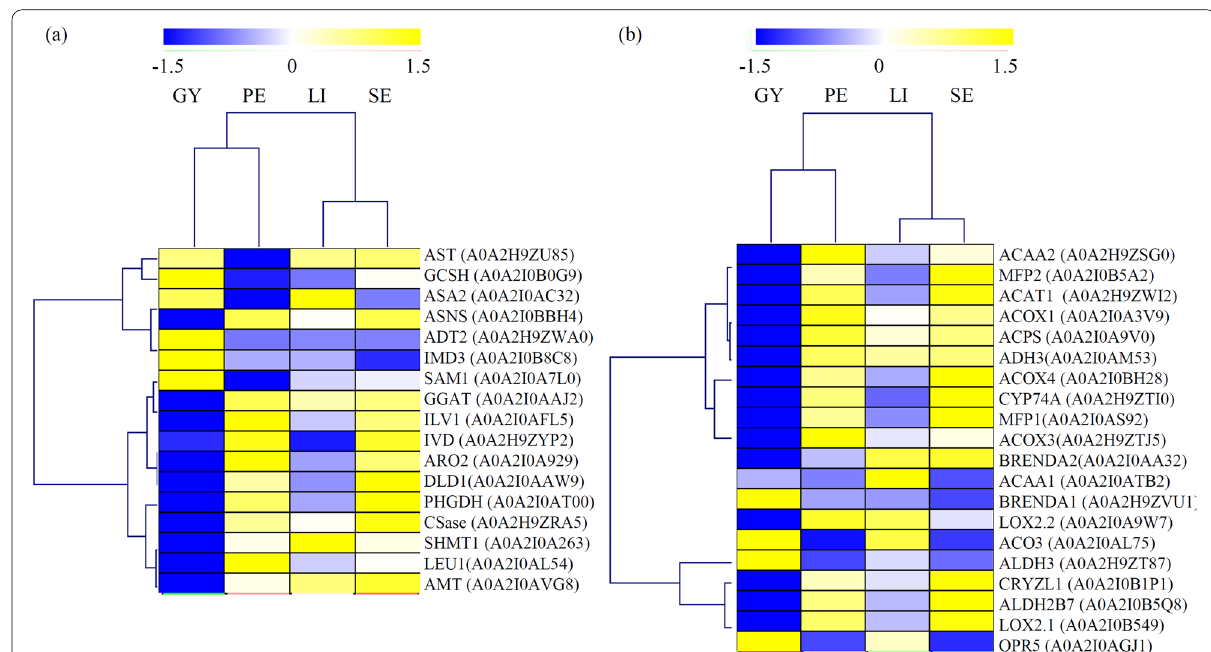
Fig. 4 Identification of amino acid metabolism- and lipid metabolism-related proteins. a Differential expression of amino acid metabolism-related proteins among four different floral organs. b Differential expression of lipid metabolism-related proteins among four different floral organs. The heatmap scale ranges from 1.5 to −